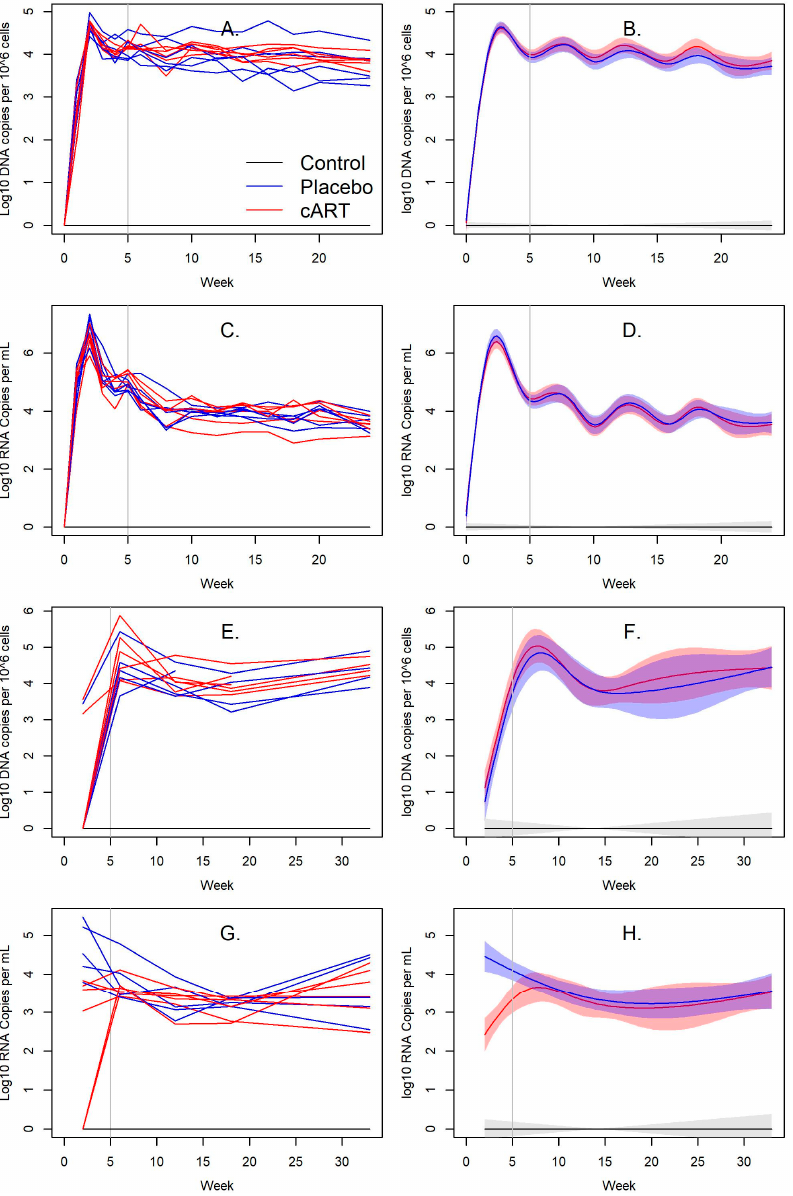
Figure 3. cART reduces salivary viral RNA loads in FIV+ cats. ( A – D ) Blood FIV viral RNA and proviral DNA loads did not differ between cART-treated FIV+ cats and placebo-treated FIV+ cats. ( E – H ) Viral RNA loads in the saliva of cART-treated FIV+ cats were lower than placebo-treated FIV+ cats, but they remained similar starting from week 6. The vertical bar indicates when cART and placebo treatment began. ( A , C , E , G ) Line plots of individual cats over time and ( B , D , F , H ) their associated spline fits from GAM analyses are